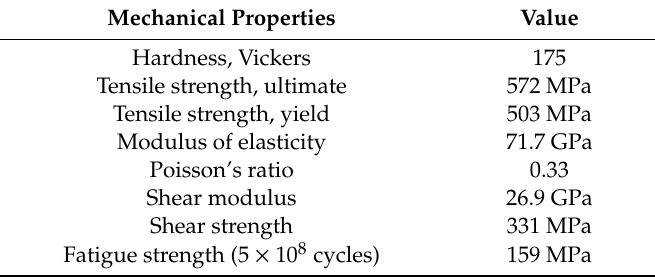
Table 2. The mechanical properties of the AA7075-T651 aluminium alloy.